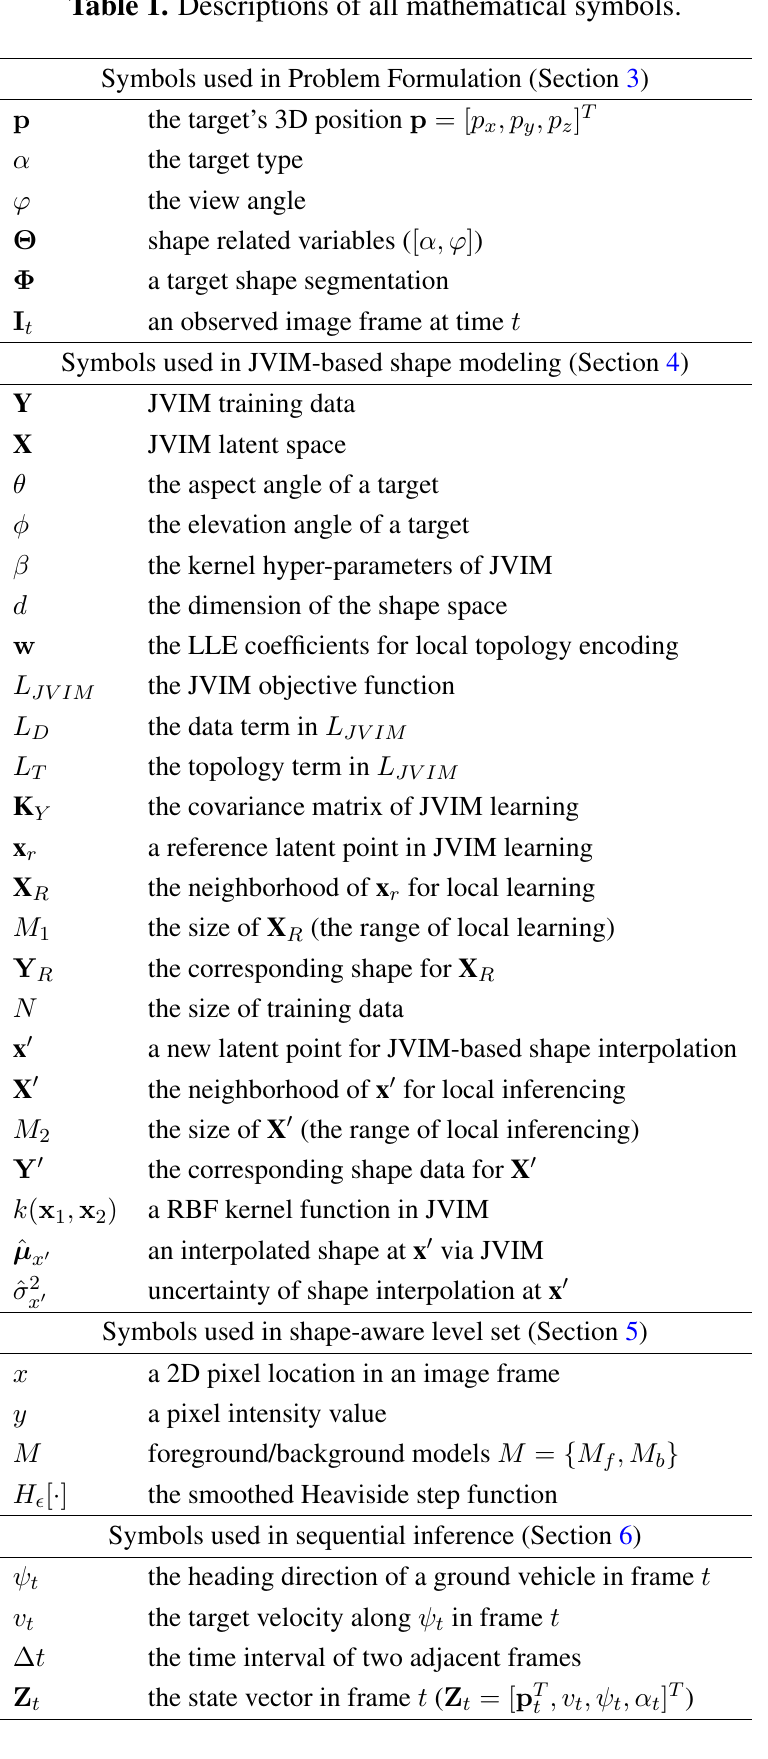
Table 1. Descriptions of all mathematical